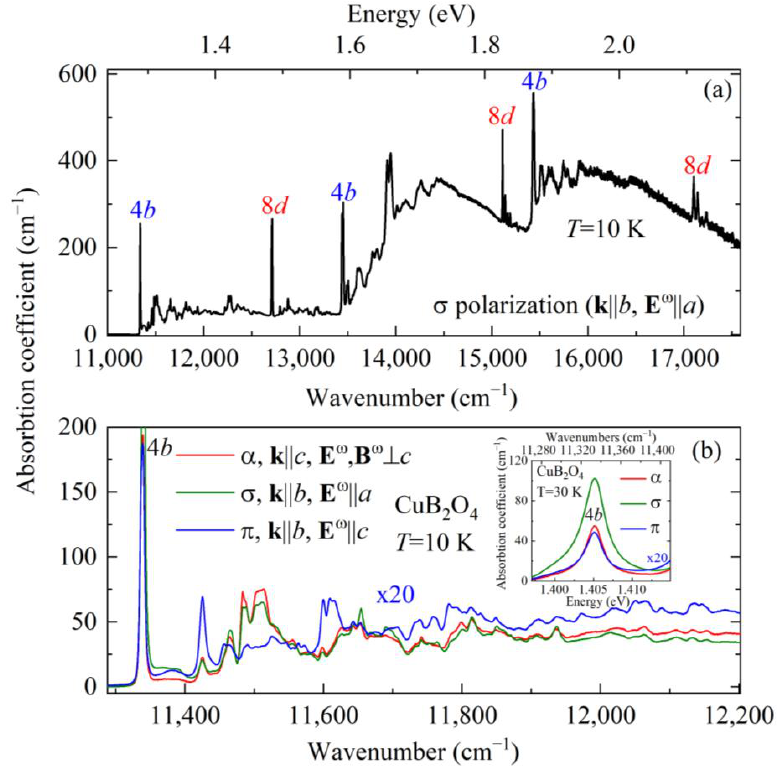
Figure 2. Absorption spectra of a CuB 2 O 4 sample at the temperature 10 K in the spectral range ( a ) of all ZP lines in the σ ( k ∥ b , E ω ∥ a ) polarization; ( b ) of the lowest-frequency ZP line and accompanying vibronic satellites in the α ( k ∥ c , E ω , B ω ⊥ c , red curve), σ ( k ∥ b , E ω ∥ a , green curve), and π ( k ∥ b , E ω ∥ c , blue curve) polarizations. Inset shows the lowest-frequency ZP line in the polarized spectra of paramagnetic CuB 2 O 4 at 30 K in the paramagnetic region.